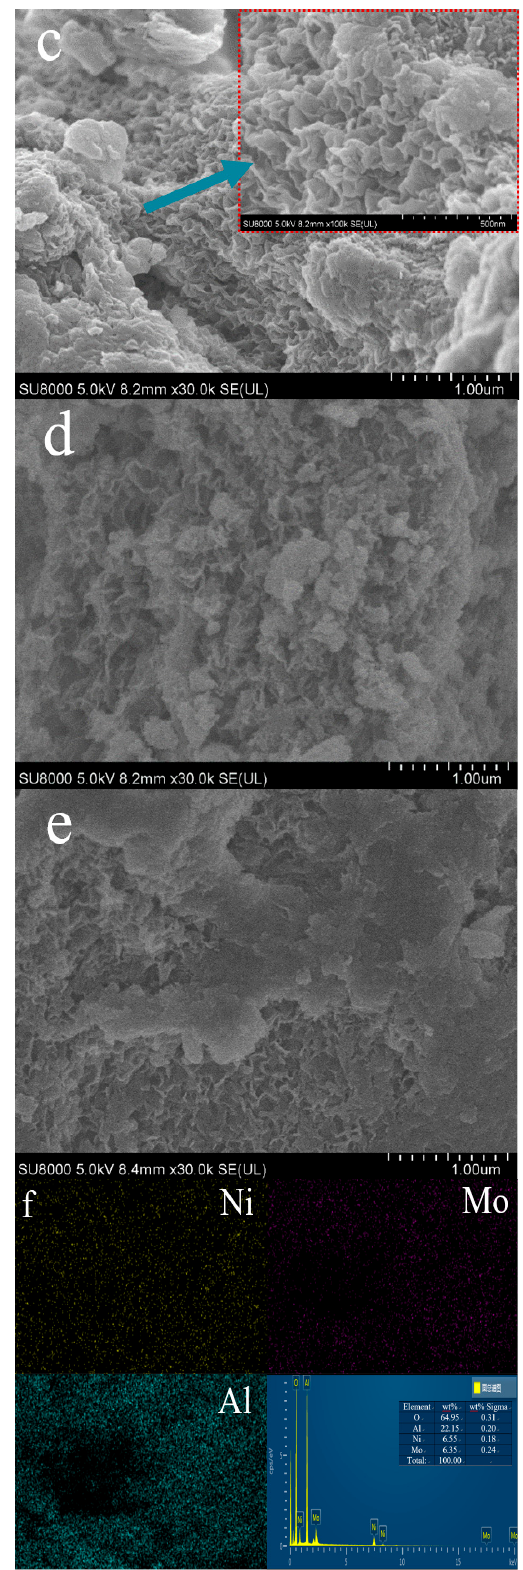
Figure 1. SEM images of ( a ) Ni 10 Mo 2 . 5 Al, ( b ) Ni 10 Mo 5 Al, ( c ) Ni 10 Mo 10 Al, ( d ) Ni 10 Mo 15 Al and ( e ) Ni 10 Mo 20 Al catalyst precursor; and ( f ) EDS mapping of Ni, Mo, Al elements for Ni 10 Mo 10 Al catalyst precursor.